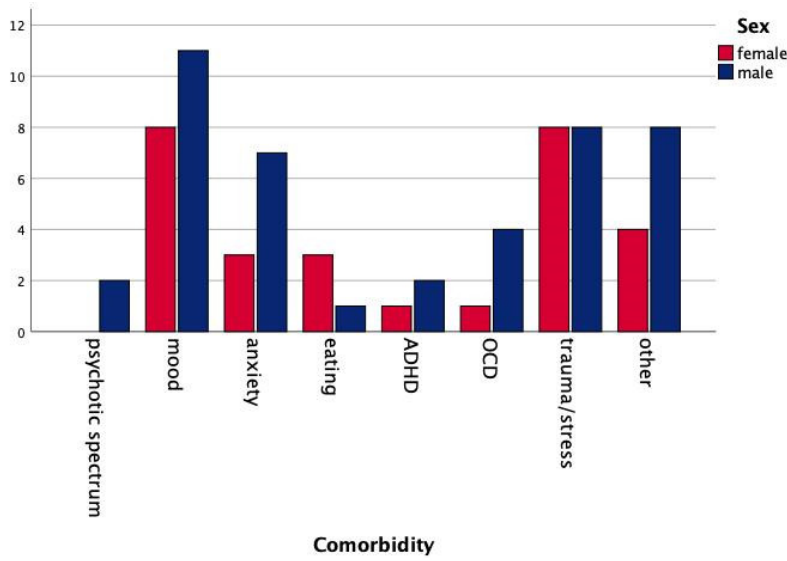
Figure 1. Frequency of comorbid mental disorders among males and